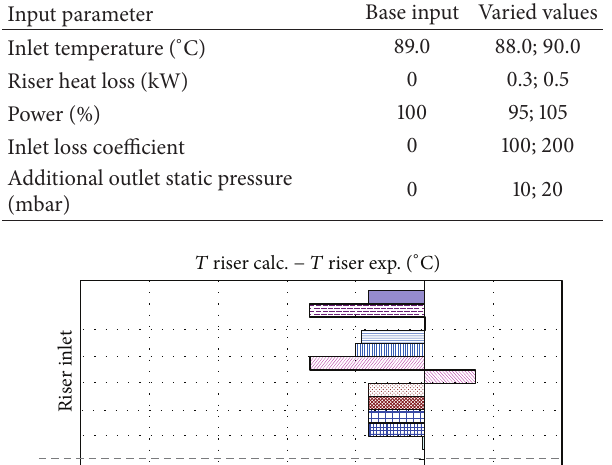
Figure 7: Difference between calculated and experimental pressure at the inlet. Steady state test